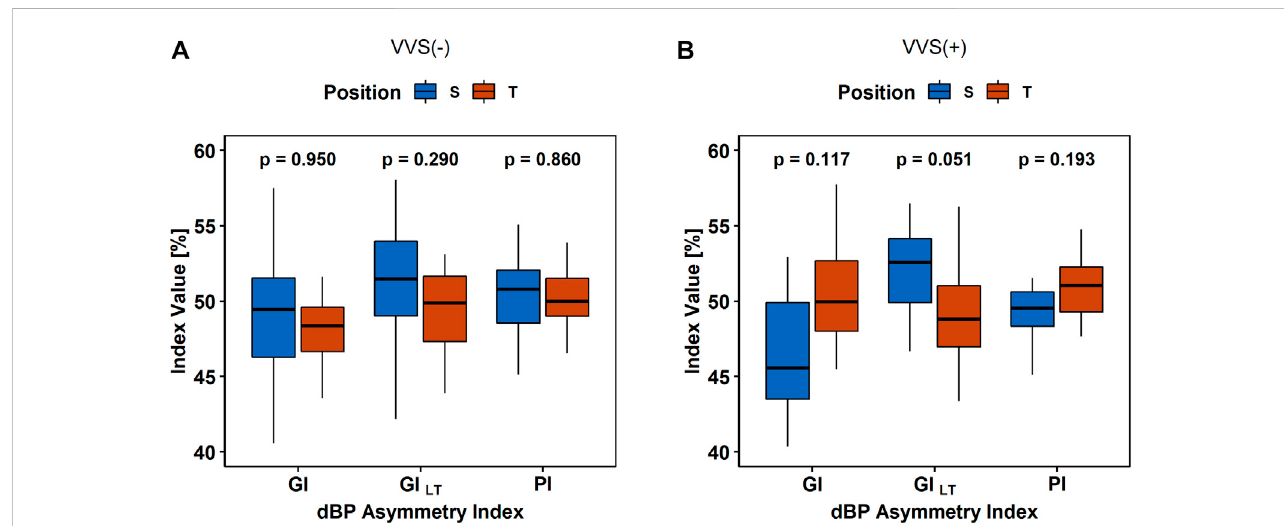
FIGURE 5 The comparison of asymmetry indices (Guzik ’ s Index, GI; Porta ’ s Index, PI; and slow-term Guzik ’ s Index, GI S ) of diastolic blood pressure (dBP) in (A) the control group (VVS ( – )) and (B) vasovagal females (VVS (+)) between the supine (S) and tilt (T) phases of the head-up tilt